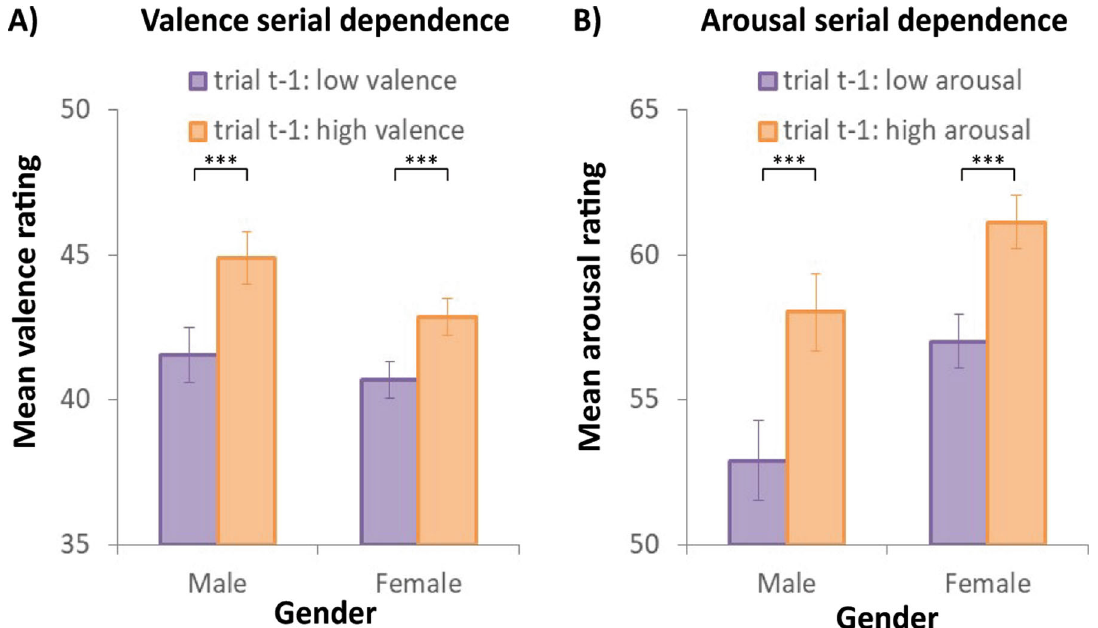
Fig. 4 The effect of gender on the valence and arousal serial dependencies. A Mean valence rating as a function of the valence rating on the previous trial for males and females. B Mean arousal rating as a function of the arousal rating on the previous trial for males and females. Error bars represent the ±2 standard error of the mean. Signi fi cance levels: * p < 0.05, ** p < 0.01, and *** p <